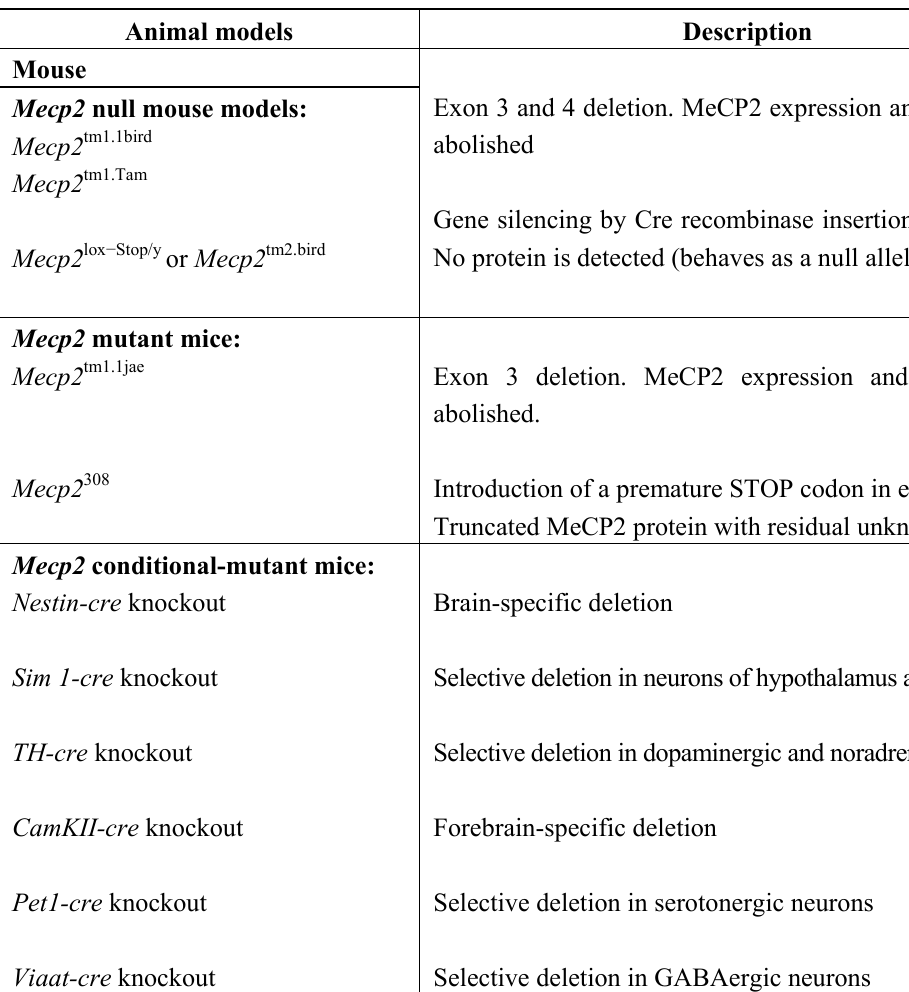
Table 2. Animal models of MeCP2